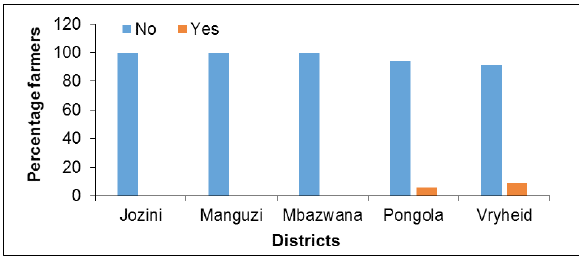
All the maize farmers in all districts surveyed sorted their maize into apparently healthy, mouldy and damaged maize before storage (results not shown). All the groundnut farmers in Jozini and Manguzi and 10% in Figure 1: Mycotoxin awareness of subsistence farmers in five districts of Mbazwana also sorted their groundnuts into apparently healthy, northern KwaZulu-Natal (chi-square: d.f.=4; p =0.17766).